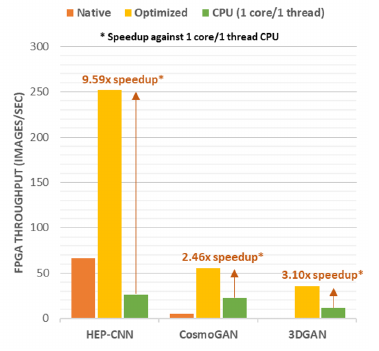
Figure 3: FPGA performance